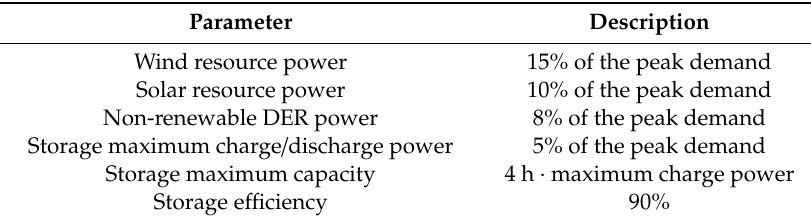
Table 2. Parameters of the model—generation and